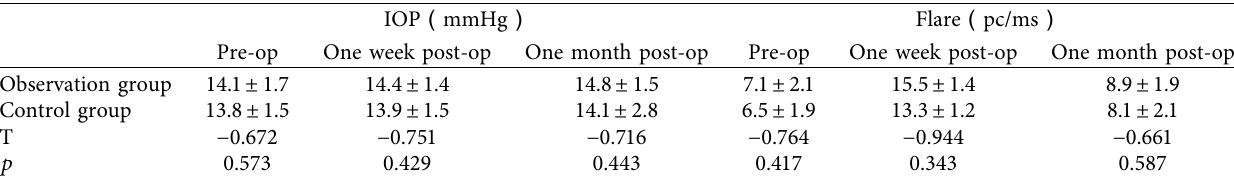
Figure 3: OCT tracking images of a 62-year-old male patient in the observation group before surgery and then at one week and one month after surgery. (a) Pre-op CMT � 474 μ m; (b) one week post-op CMT � 350 μ m; (c) one month post-op CMT � 398 μ m. Table 4: Comparison of IOP and flare at different time points between the observation group and the control